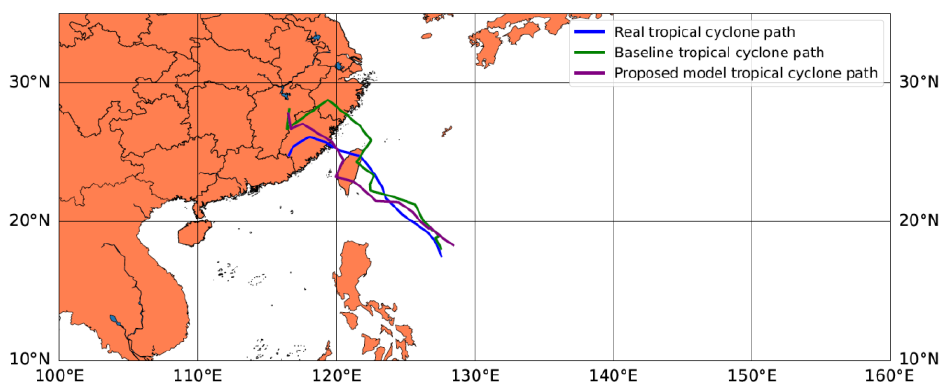
Figure 10. Visualization of 24-h path forecasting of tropical cyclone Yutu.